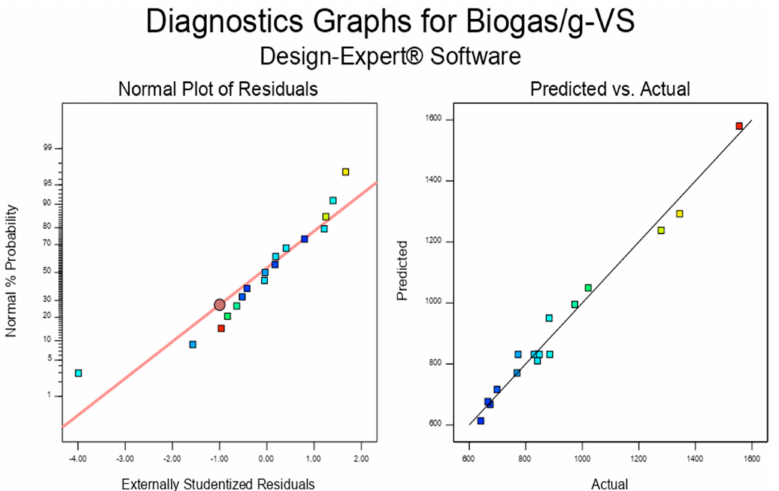
Figure 2. Normal probability and predicted vs. actual residuals plot of biogas/g-VS produced from extracted oil date